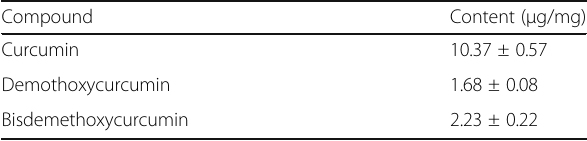
Table 1 Curcuminoids contents in FCL Compound Content ( μ